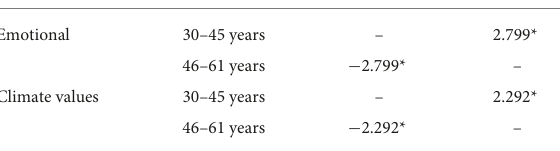
TABLE 10 Multiple comparisons in the emotional subscale of climate change perception (CCP) and climate values (CV) due to age group